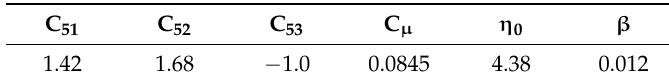
Table 3. k- ε model